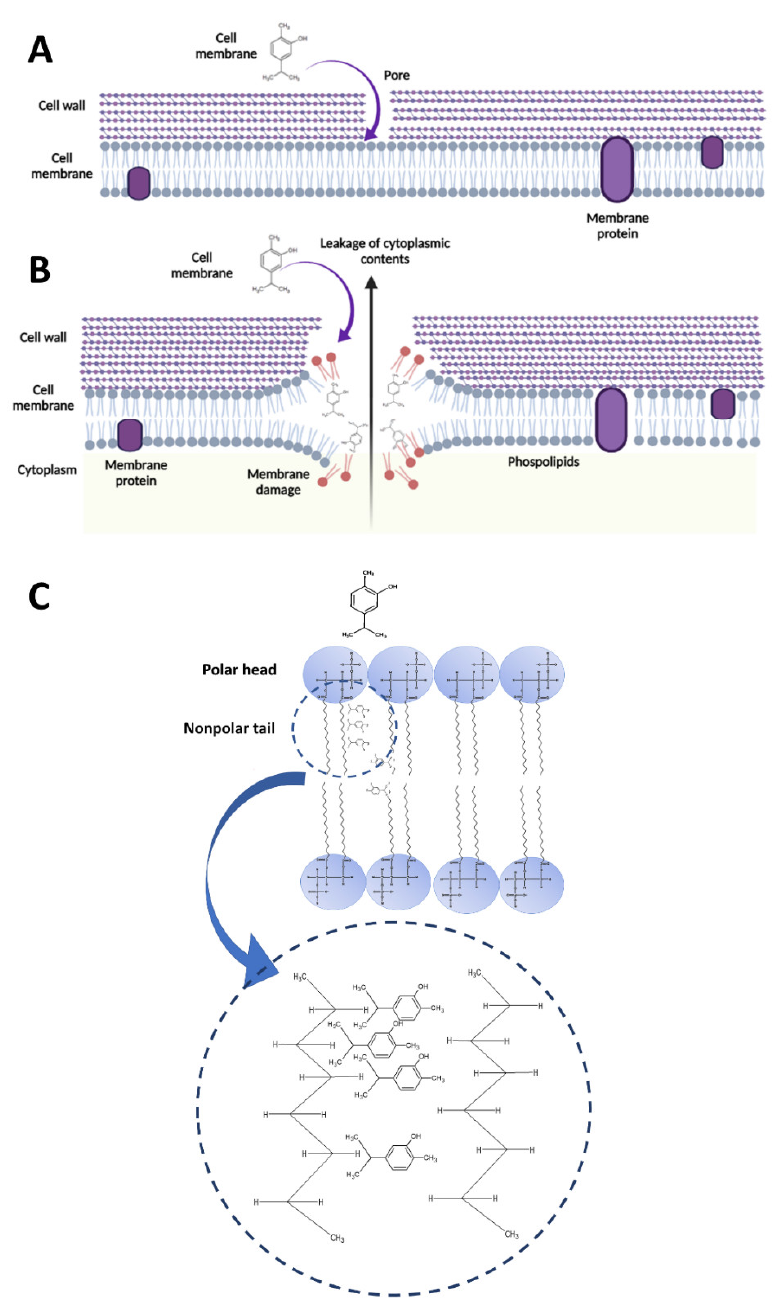
Figure 6. Potential mechanism of action of carvacrol in damaging the cell membranes of Streptococcus pyogenes . ( A ) Due to its hydrophobic nature, carvacrol penetrates through cell wall pores to the cell membrane and ( B ) interacts with the bacterial cytoplasmic membrane lipid bilayer. Carvacrol may align between fatty acid chains of the membrane phospholipids, specifically P.G., P.E., and CL, causing the expansion and destabilization of the membrane structure by increasing the fluidity and permeability. As a result, cytoplasmic cell contents will be leaking from the cytoplasm, which ultimately causes cell death. ( C ) The accumulation of carvacrol in hydrophobic phases, which occu- pies more than the usual space between fatty acyl chains, subsequently causes some conformational changes in the phospholipid bilayer. P.G.: Phosphatidylglycerol; P.E.: Phosphatidylethanolamine; CL: